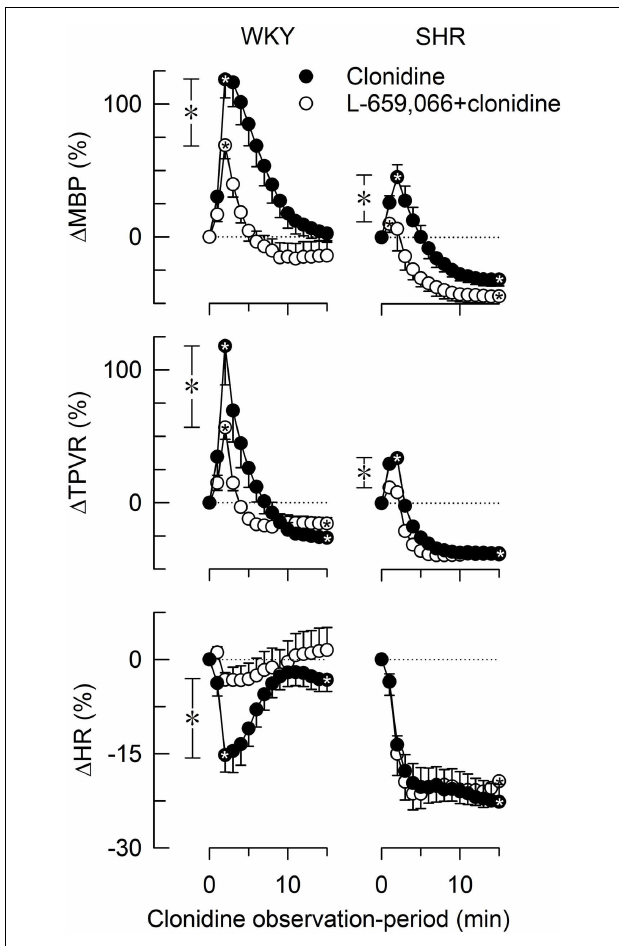
FIGURE 1 |The changes in MBP,TPVR, and HR in response to the centrally active, non-selective α 2 AR agonist clonidine, without or with prior administration of the peripherally restricted, non-selective α 2 AR antagonist L-659,066. After curve evaluations, significant responses ( within symbols) and group differences at peak response (*in brackets left of curves) and at 15min (*in brackets right of curves) were detected as indicated. Cardiovascular baselines prior to clonidine are shown in Table 2 . ,* P ≤